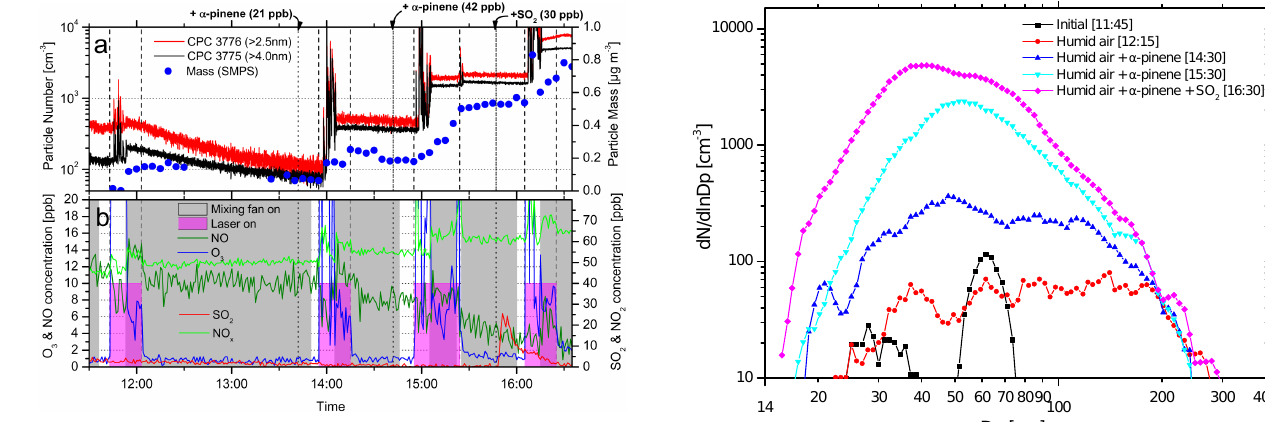
Fig. 9. Laser-induced particle formation in the presence of α -pinene and SO 2 at 283K and a relative humidity decreasing from 94 to 89%, (a) evolution of particle number (red and black line) and mass (blue circles); (b) evolution of NO (dark green line), NO x (light green line), O 3 (blue line), SO 2 (red line) mixing ratios and opera- tion of fan (grey shaded area) and laser (pink area, 140mJ).